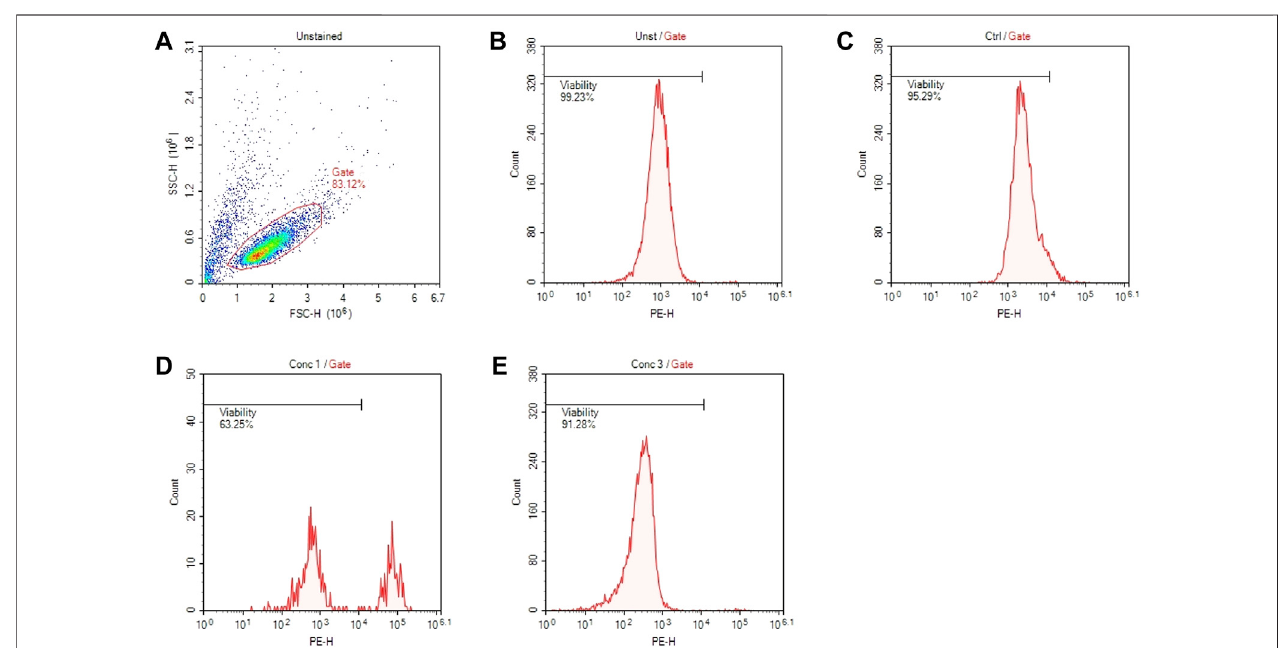
FIGURE 2 | Gating strategies for cell viability assessment. (A) Representative dot plot diagram offorward-scatter (FSC) and side-scatter (SSC) light. The threshold level for FSC-H was set to exclude signals from cellular debris. (B) Representative histogram of viability of non-treated and non-stained cells (Unst). (C) Representative histogram of control cells stained with PI. (D) Representative histogram of cells treated with a concentration of drug that resulted cytotoxic (Conc 1). (E) Representative histogram of cells treated with a concentration of drug that resulted non-cytotoxic (Conc 3).